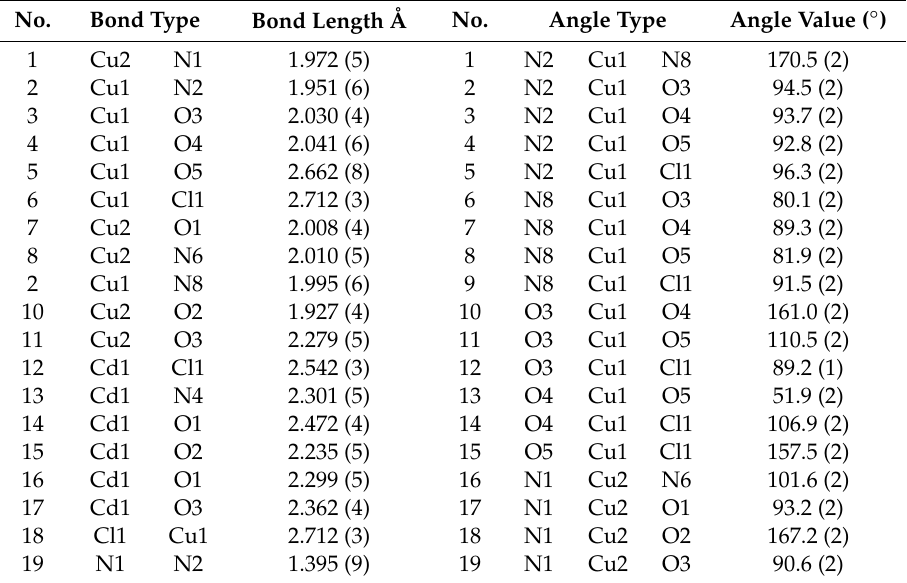
Table 1. Selected bond (Å) and angles lengths ( ◦ ) of the desired cluster.